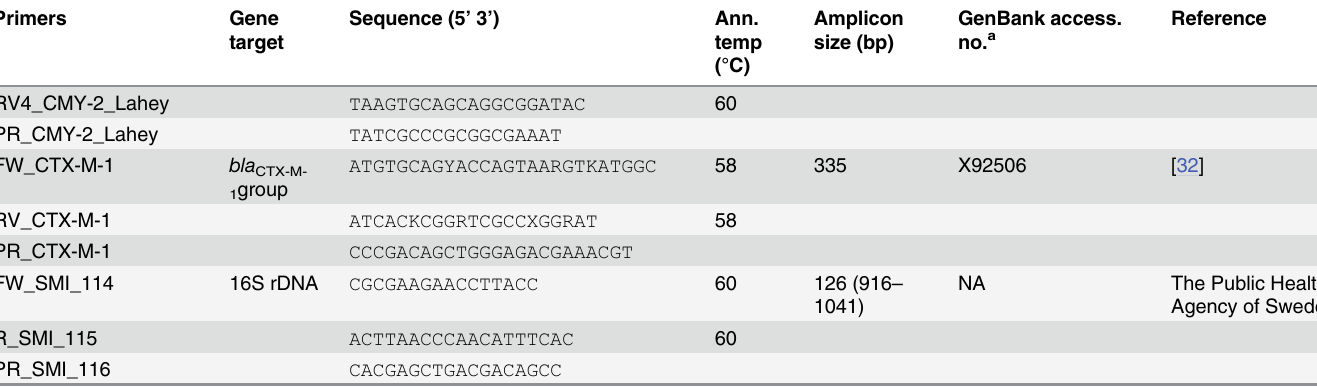
fecal samples collected for qPCR analysis. The amplicons were generated using the primers in S1 Table using a T3000 thermocycler for standard PCR (Biometra, Göttingen, Germany).